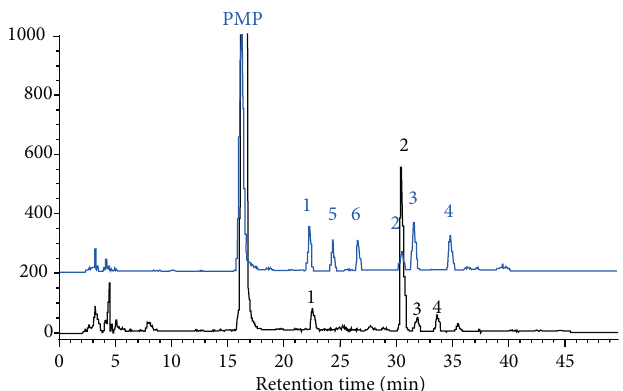
Figure 1: PSP component analysis by HPLC. 1: mannose; 2: glucose; 3: galactose; 4: trehalose; 5: glucuronic acid; 6: galacturonic acid.